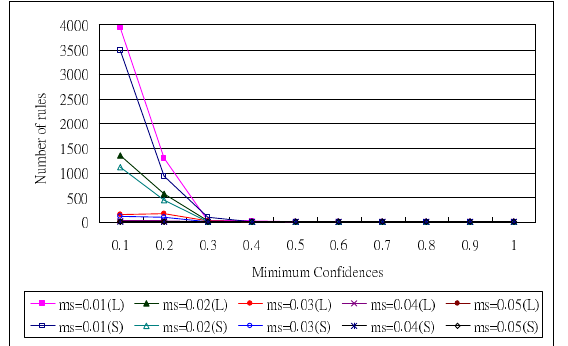
Fig. 7. The number of rules derived by the proposed approach for the exponential dataset